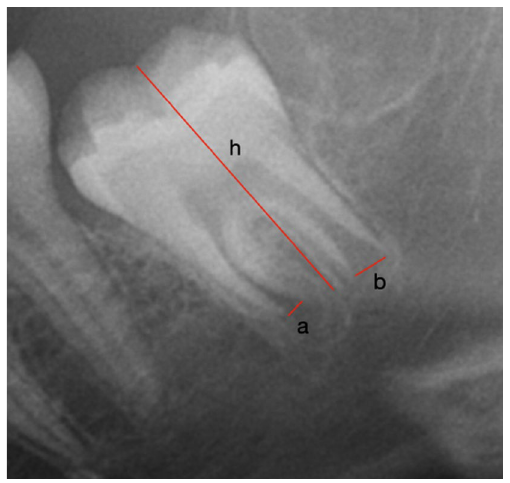
Figure 2. Representation of Cameriere method. The numerical value is obtained with the formula (a +